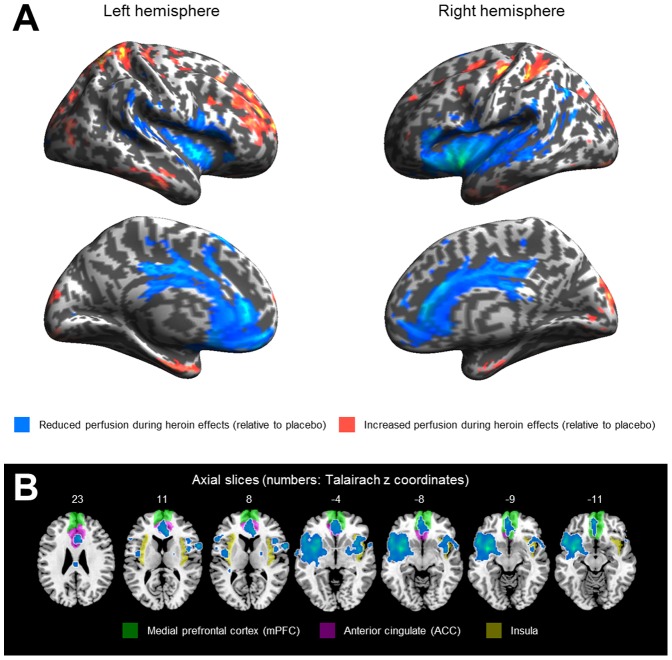
Altered regional perfusion in heroin in comparison to placebo condition.A) Relative hypo- (blue) and hyperperfusion (red) in heroin condition projected on an inflated brain (threshold: p<0.05). Hyperperfusion was not significant. B) Significant hypoperfusion (blue) in heroin condition (threshold: p<0.01; FEW corrected p<0.05). The z coordinate shows the position of each slice in reference to the Talairach atlas (see Table 3). The medial prefrontal cortex, the anterior cingulate cortex, and the insular cortex are shown in different colors, in order to clarify the spatial relationship to the significant clusters.